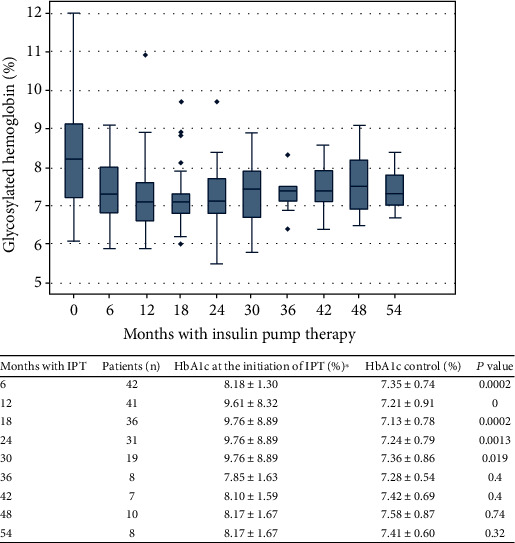
HbA1c levels prior to the beginning of insulin pump therapy (time 0) and during the next months (6 to 54 months). Results are reported as median values and interquartile ranges. In the table, we report the HbA1c level at the beginning of the therapy and its control after the initiation of IPT.